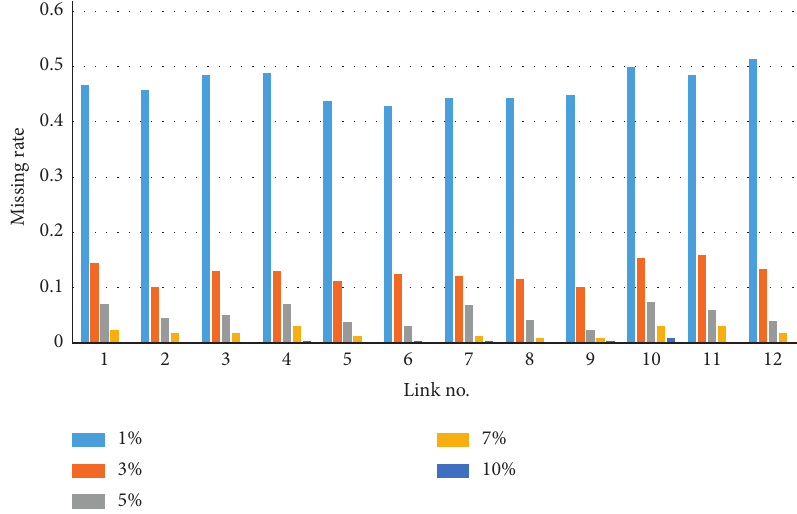
Figure 3: Data-missing rate on different links.